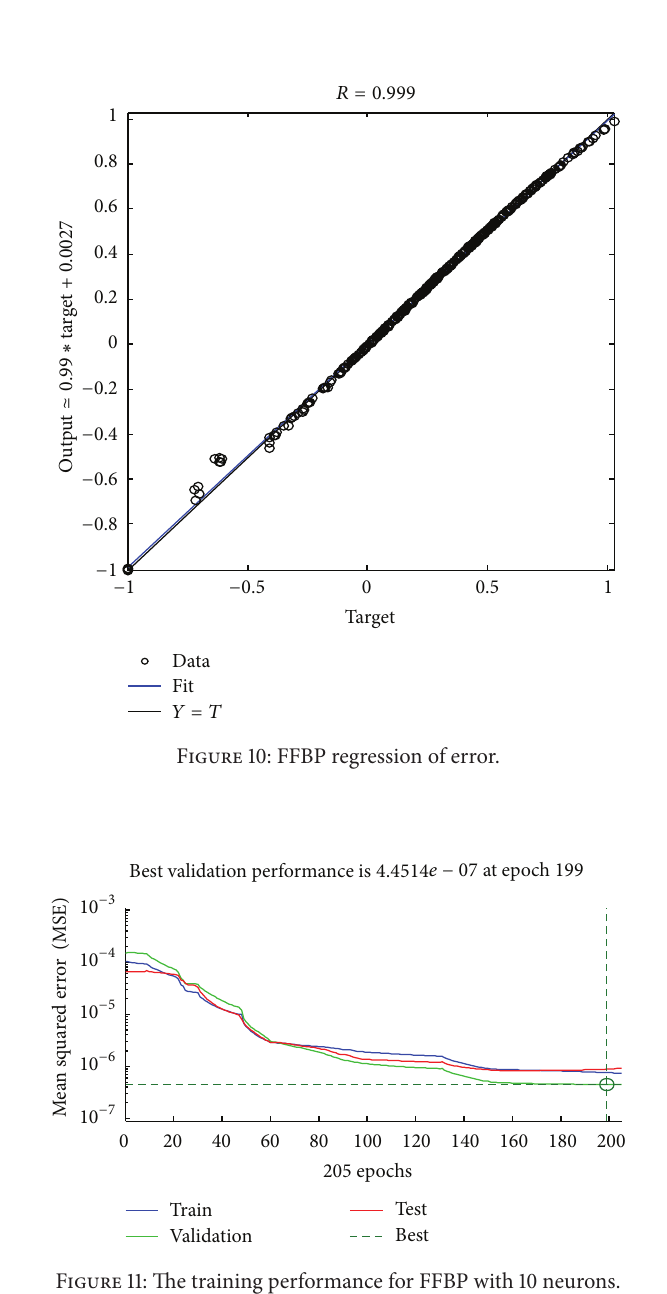
Figure 9: Results for real data and FFBP for 2010 with 10 hidden neurons.